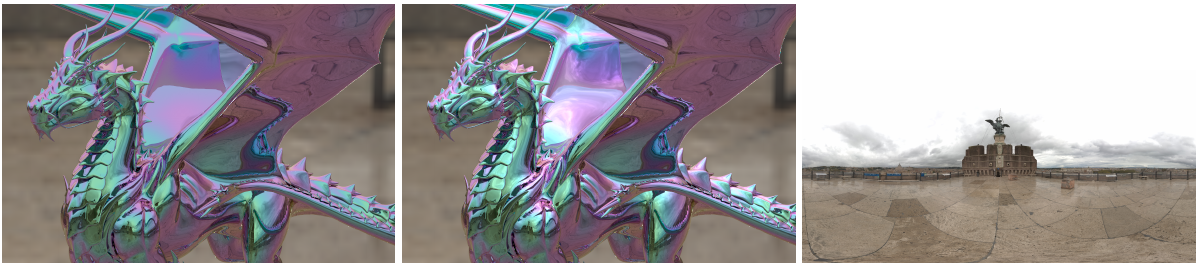
Figure 11. Comparison of IBL rendering with LDR and HDR environment maps. The left image is rendered with an LDR-HS environment map, the middle image is rendered with an HDR-HS environment map, and the right image is the environment map used for spectral IBL